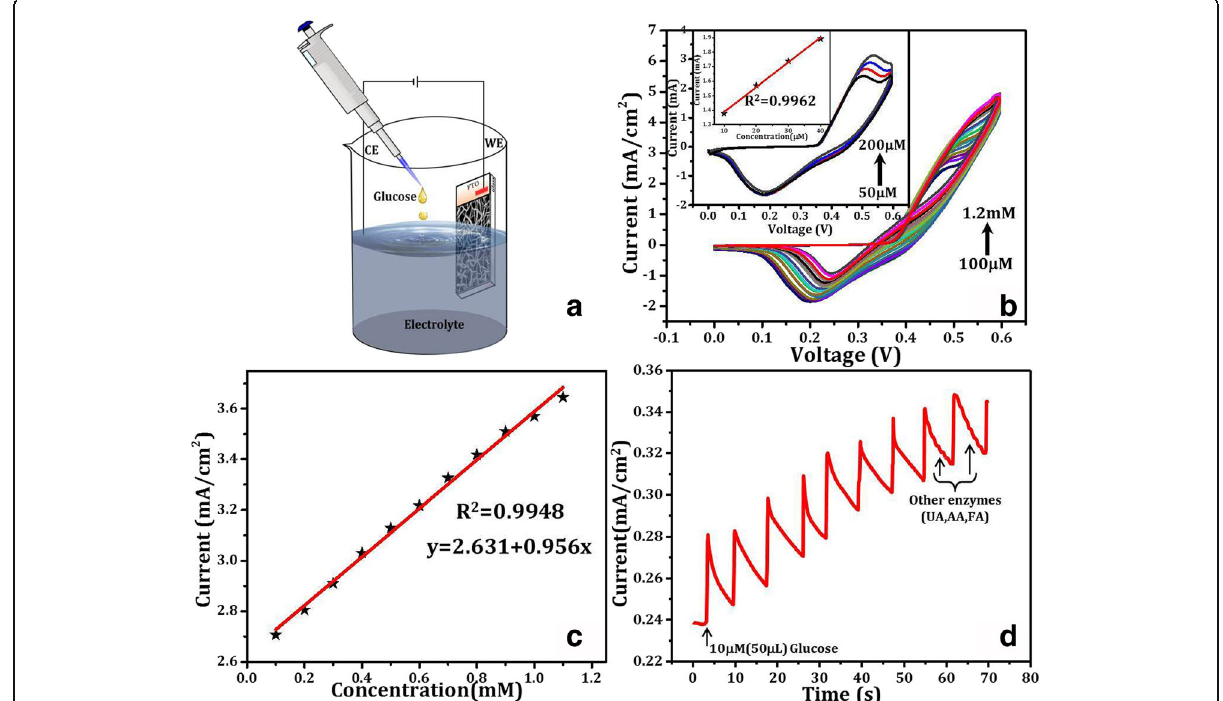
Fig. 4 a Schematic illustration of electrochemical glucose sensing setup using NiO-NPs@FTO as working electrode with supporting electrolyte NaOH (0.1 M). b Sequential glucose addition of 50 μ M during CV scan with its magnifying view in the inset. c Linear relation of glucose concentration with current d amperometric response (at +0.5 V) on a 10- μ M glucose